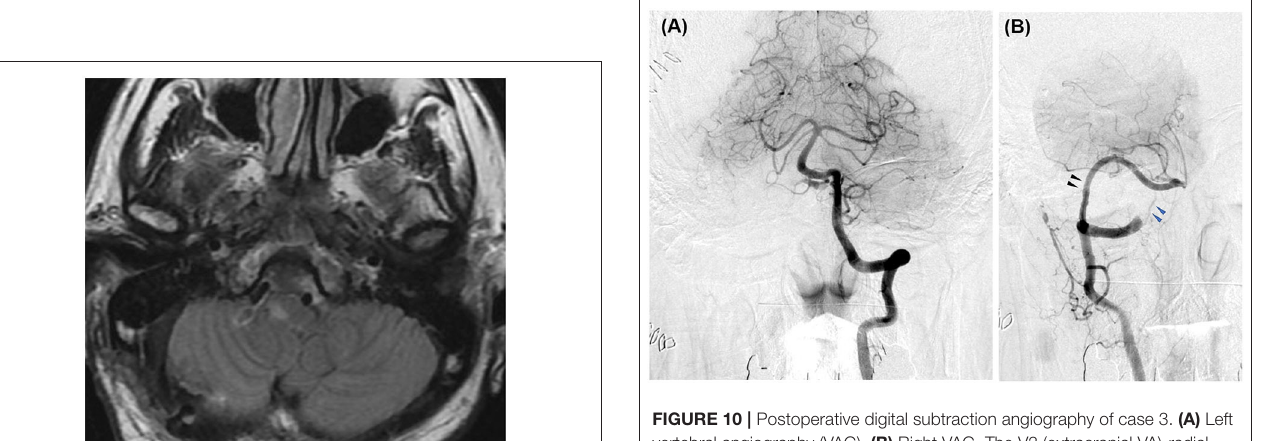
FIGURE 10 | Postoperative digital subtraction angiography of case 3. (A) Left vertebral angiography (VAG). (B) Right VAG. The V3 (extracranial VA)-radial artery graft (RAG)-posterior inferior cerebellar artery (PICA) bypass broadly fed the anterior inferior cerebellar artery-PICA region (black arrowhead). The flow of the VA main trunk went into the relatively thick branch feeding the lower vermis and the medulla oblongata (blue